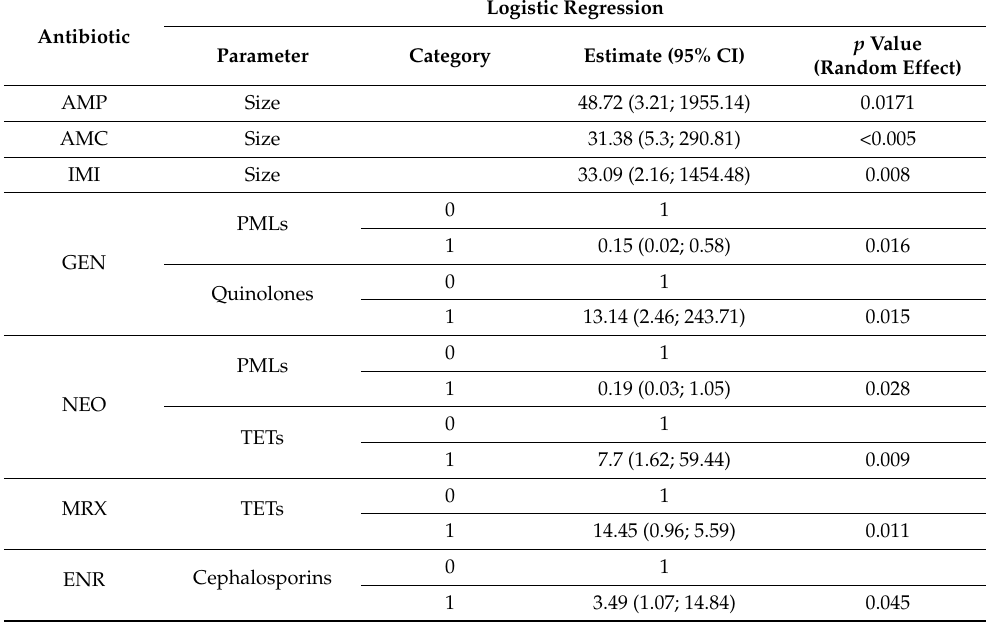
Table 6. Association of AMR with herd characteristics and administration of